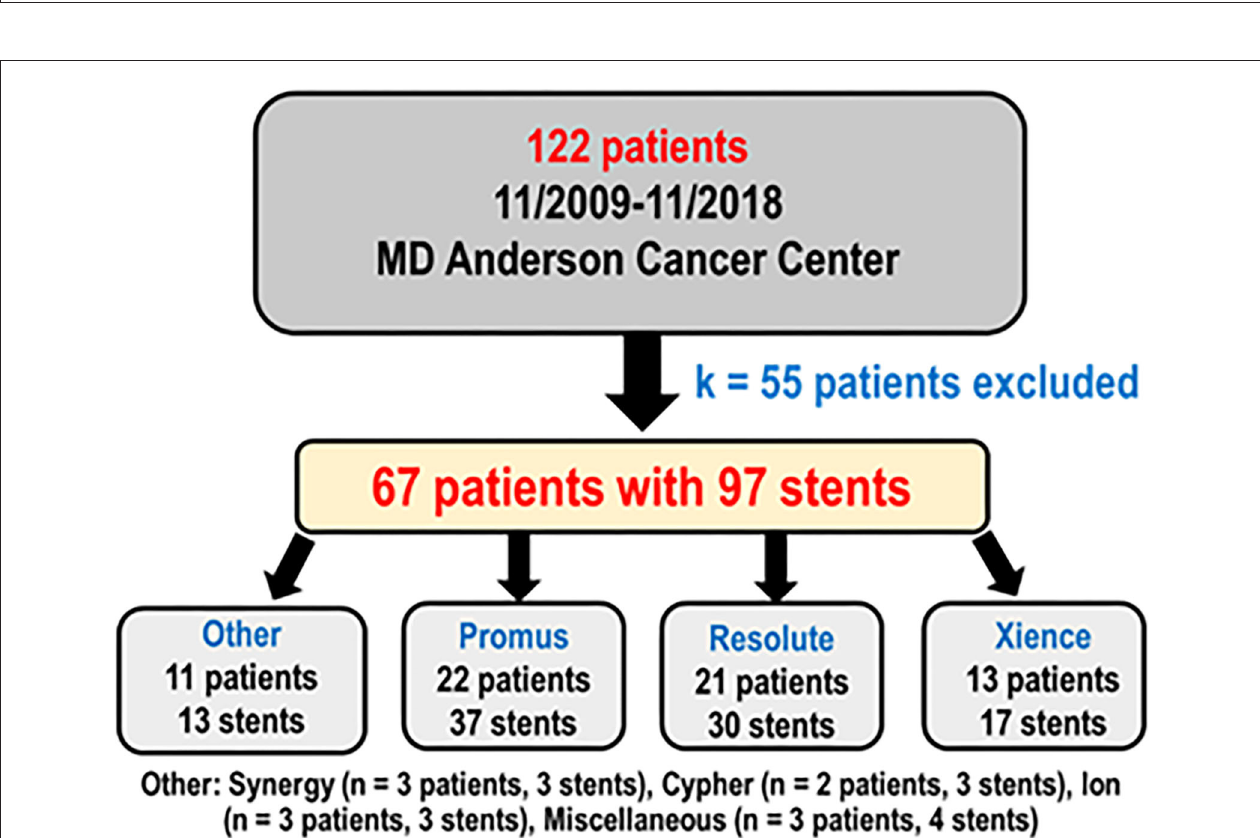
FIGURE 2 | Study design and stent brand